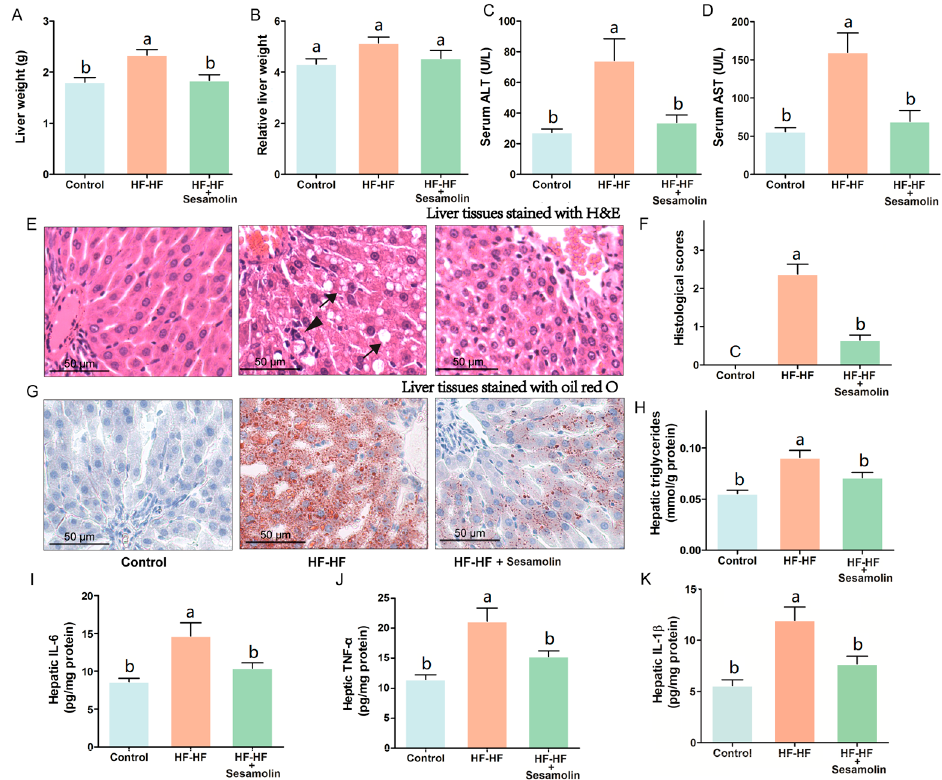
Figure 3. Sesamolin alleviates hepatic steatosis and inflammation progression in HF-HF diet-fed mice. ( A ) Liver weight, and ( B ) relative liver weight. Serum levels of ( C ) ALT and ( D ) AST. ( E ) Representative images of liver tissues stained with H&E: ↓ , ballooning degeneration of hepatocyte, and foam cell; ▼ , inflammatory cells within the hepatic lobules. ( F ) Histological scores of liver stained with H&E. ( G ) Representative images of liver tissues stained with oil red O, and ( H ) hepatic triglycerides level. ( I – K ) Hepatic levels of IL ‐ 6, TNF ‐α , and IL ‐ 1 β . Results are presented as mean ± SEM (n = 8). Different letters express significant differences, p < 0.05.